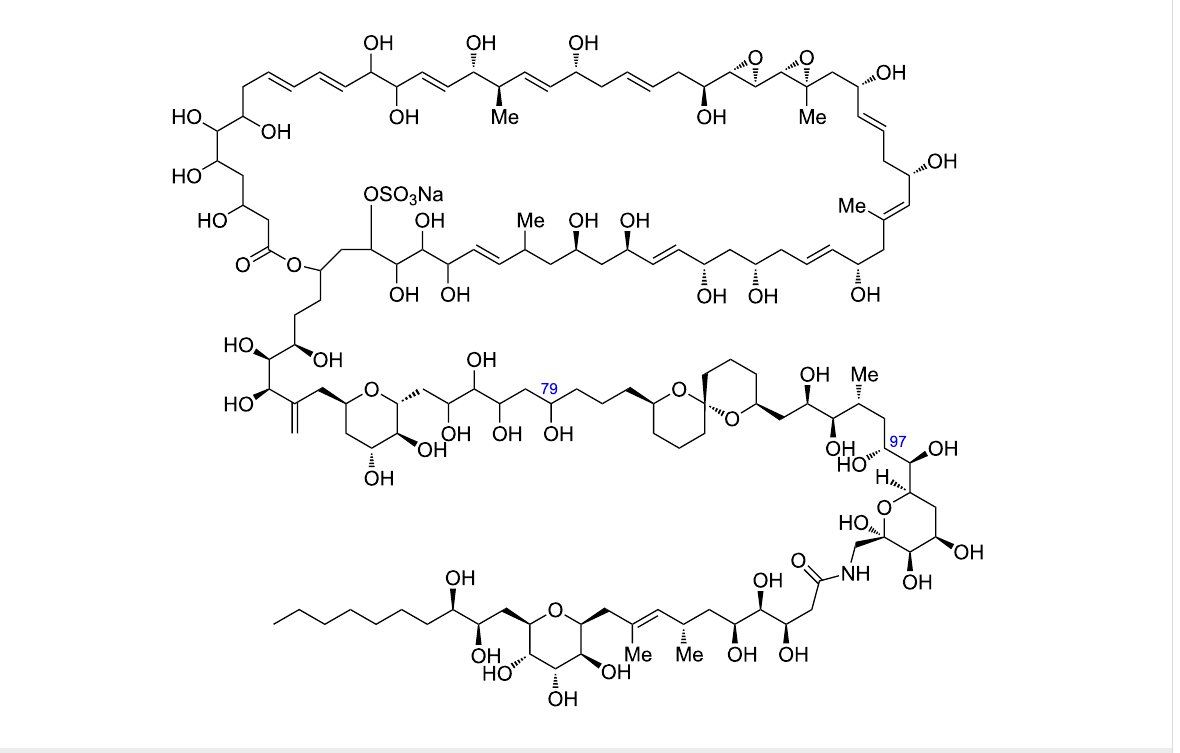
Figure 1: Structure of symbiodinolide ( 1 ).